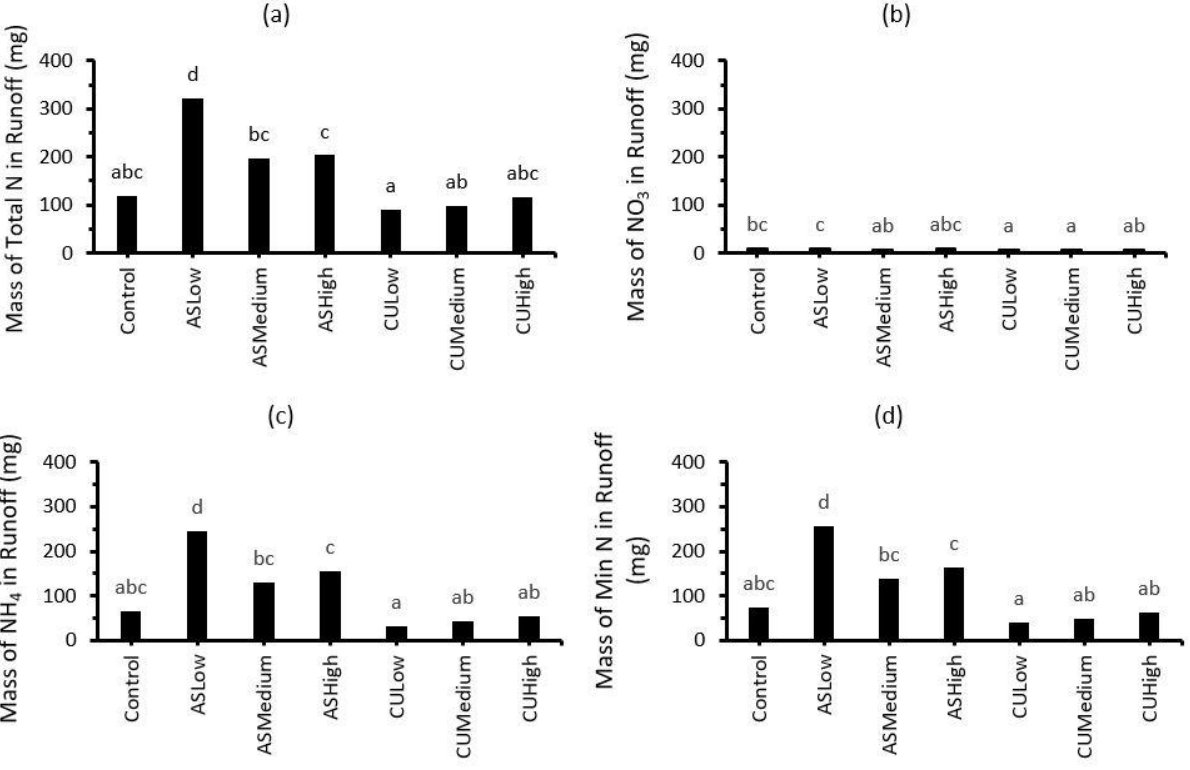
Figure 4. Masses of ( a ) total N, ( b ) NO x , ( c ) NH 4 and ( d ) mineral N (NH 4 + NO x ) in runoff from the Control, ASLow, ASMed, ASHigh, CULow, CUMed and CUHigh treatments. Bars represent the mean of three replicates (n = 3). Same lowercase alphabets indicate statistically non-significant dif- ferences between treatments at p <